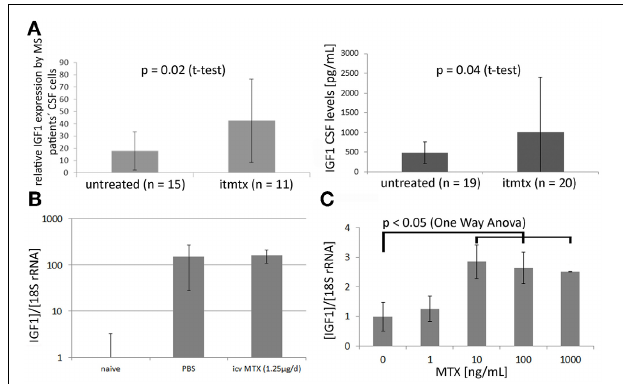
FIGURE 5 | Methotrexate modulates IGF1 expression in CNS and by embryonic stem cells. (A) Left: The CSF cell transcriptome of 15 untreated progressive MS and 11 ITMTX treated patients was analyzed by microarray hybridization. Right: IGF1 levels were quantified in cell-free CSF samples obtained from 19 control patients and 20 MS patients using a commercially available IGF1 ELISA (RandD Systems). (B) Mice were fed with cuprizone for 4 weeks. Additionally, they either received icv MTX or PBS. RNA was isolated from the midline section of corpus callosum and IGF1 expression determined by RealTime PCR. Bars represent IGF1 expression in respective mouse group standardized to IGF1 expression in corpus callosum of treatment naïve mice. (C) Methotrexate increases the expression of IGF1 by murine embryonic-derived oligodendroglial progenitor cells. 100,000 ES-OPCs cells incubated with different amounts of methotrexate diluted in differentiation medium. After 10d the expression of IGF1 was determined by RealTime-PCR (One-Way ANOVA). Error bars represent Standard Deviations.